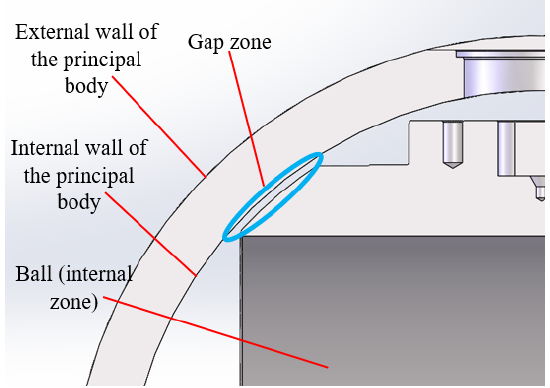
Figure 15. Gap between the principal body and the DN500 ball.